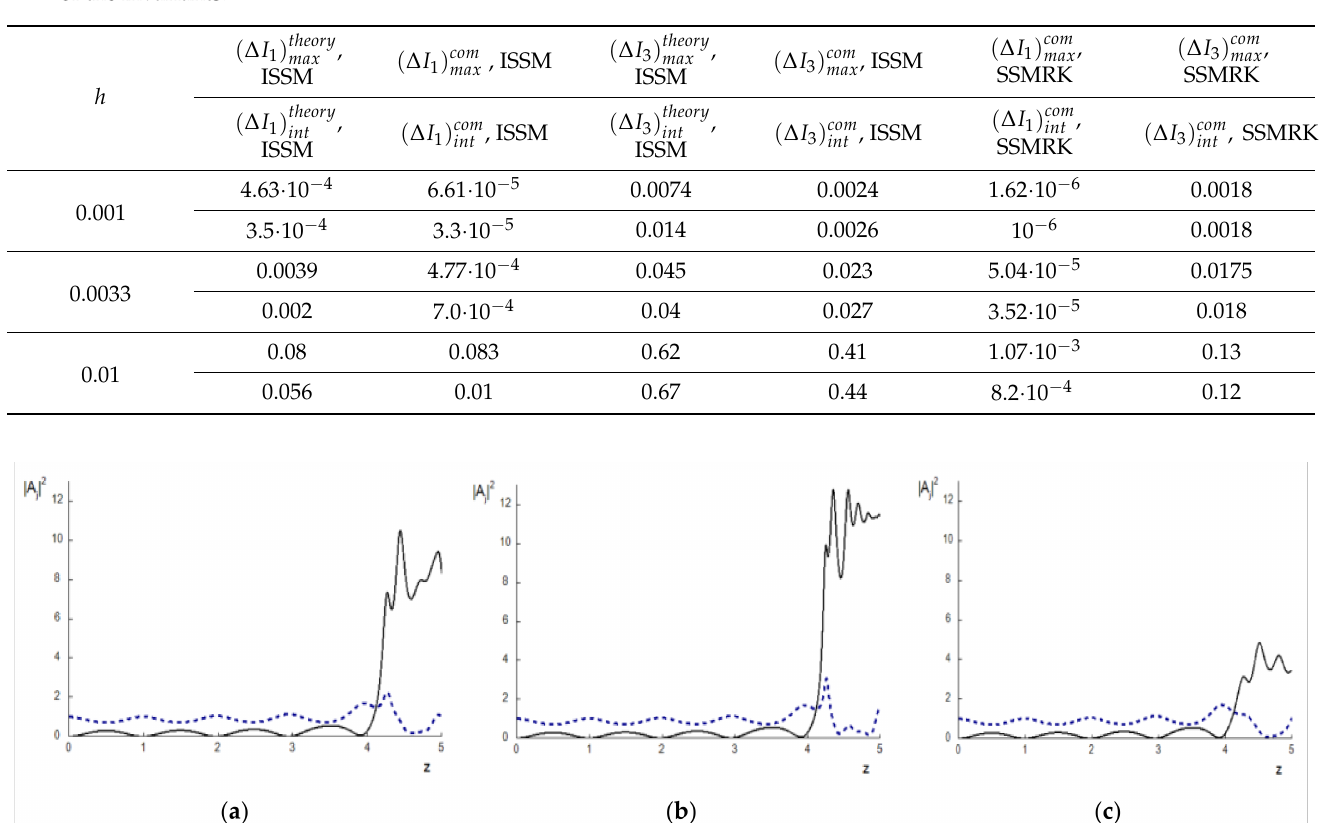
Table 4. Influence of the spatial step on the first invariant and the Hamiltonian deviation when using the ISSM and the SSMRK for computation. The upper row corresponds to the local invariant deviation, the low row–to the integral deviation of the invariants.